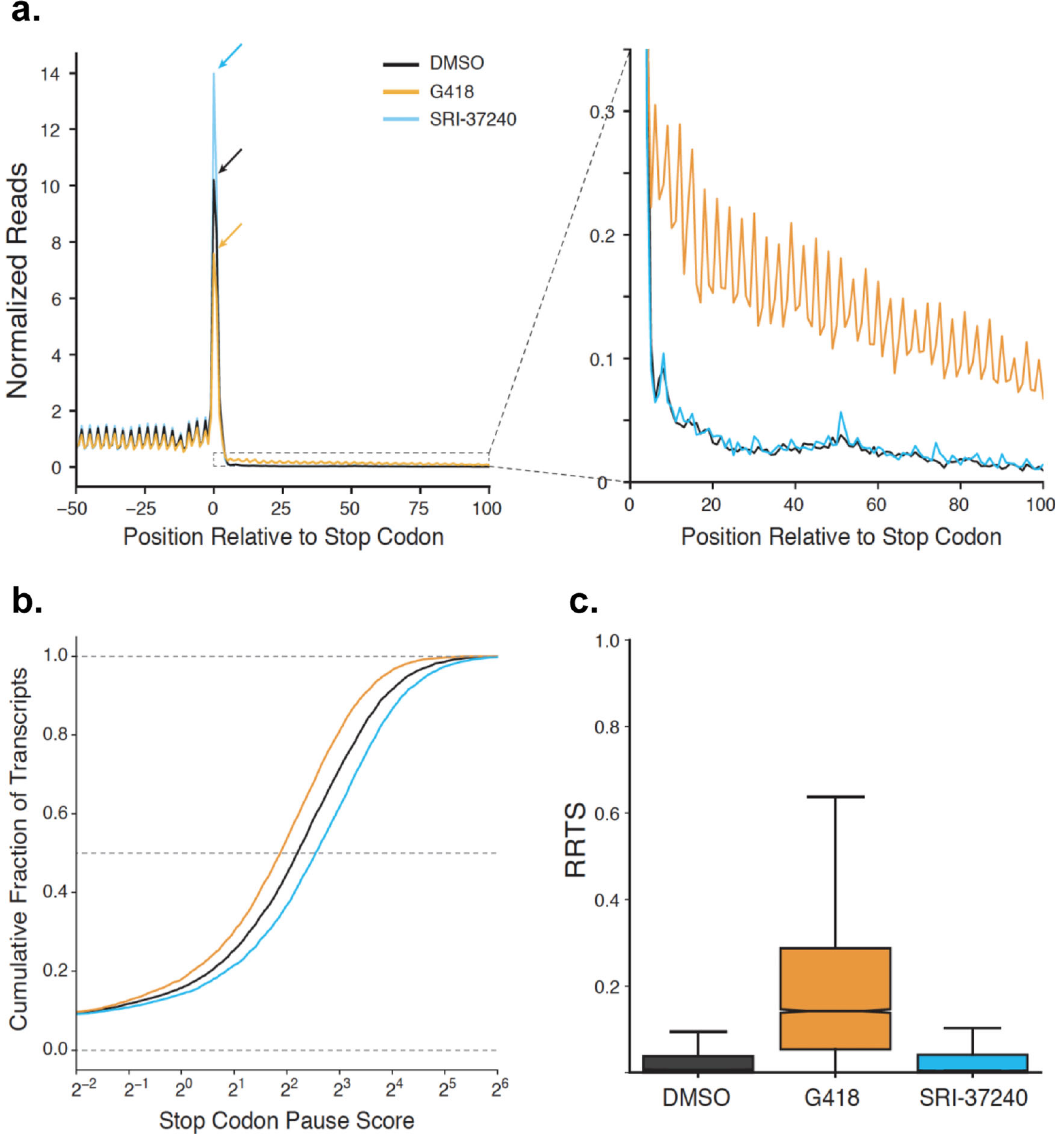
Fig. 3 Exploring the effect of SRI-37240 on global cellular translation termination using ribosome pro fi ling. HEK293T cells were treated with 0.1% DMSO (black), 0.5 mg/mL G418 (orange), or 10 µ M SRI-37240 (cyan) for 24 h. a Metagene plots showing normalized ribosome densities relative to the position of the termination codon at position 0. Arrows indicate the peak for ribosomes at the stop codon to facilitate comparison (left). A magni fi ed view of 3 ′ UTRs allows comparison of translation in this region (right). b Stop codon pause scores were calculated for each transcript and compared using cumulative histograms. G418 globally decreased ribosome density at stop codons ( P = 1.4 × 10 − 248 ) while SRI-37240 increased ribosome density at stop codons ( P = 8.6 × 10 − 302 , two-sided Wilcoxon signed-rank test). c RRTS values for all transcripts are compared between treatments using box and whisker plots. Median values are indicated with the notch showing 95% con fi dence intervals and whiskers indicate 1.5 times the interquartile range. Outliers are excluded from the plot. G418 increased RRTS values while SRI-37240 did not signi fi cantly increase RRTS values while SRI-37240 did not signi fi cantly increase RRTS values relative to DMSO ( P < 0.0001 and P = 0.11 respectively, one-sided Mann – Whitney U ). Source data is available as a source data fi